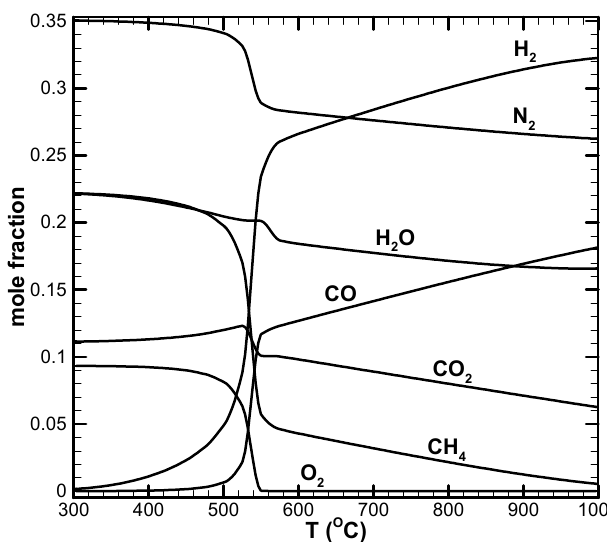
Figure 4. Variations of species mole fraction of the TR process using the base operation conditions listed in Table 1.